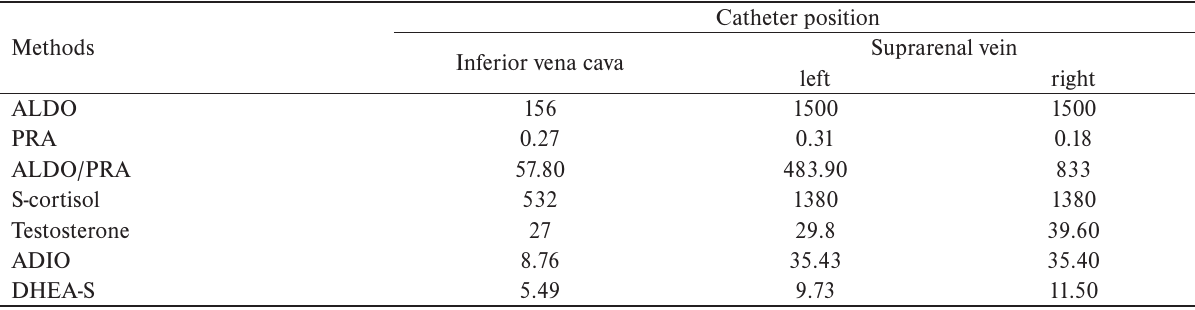
Table 1. Preoperative adrenal veins sampling